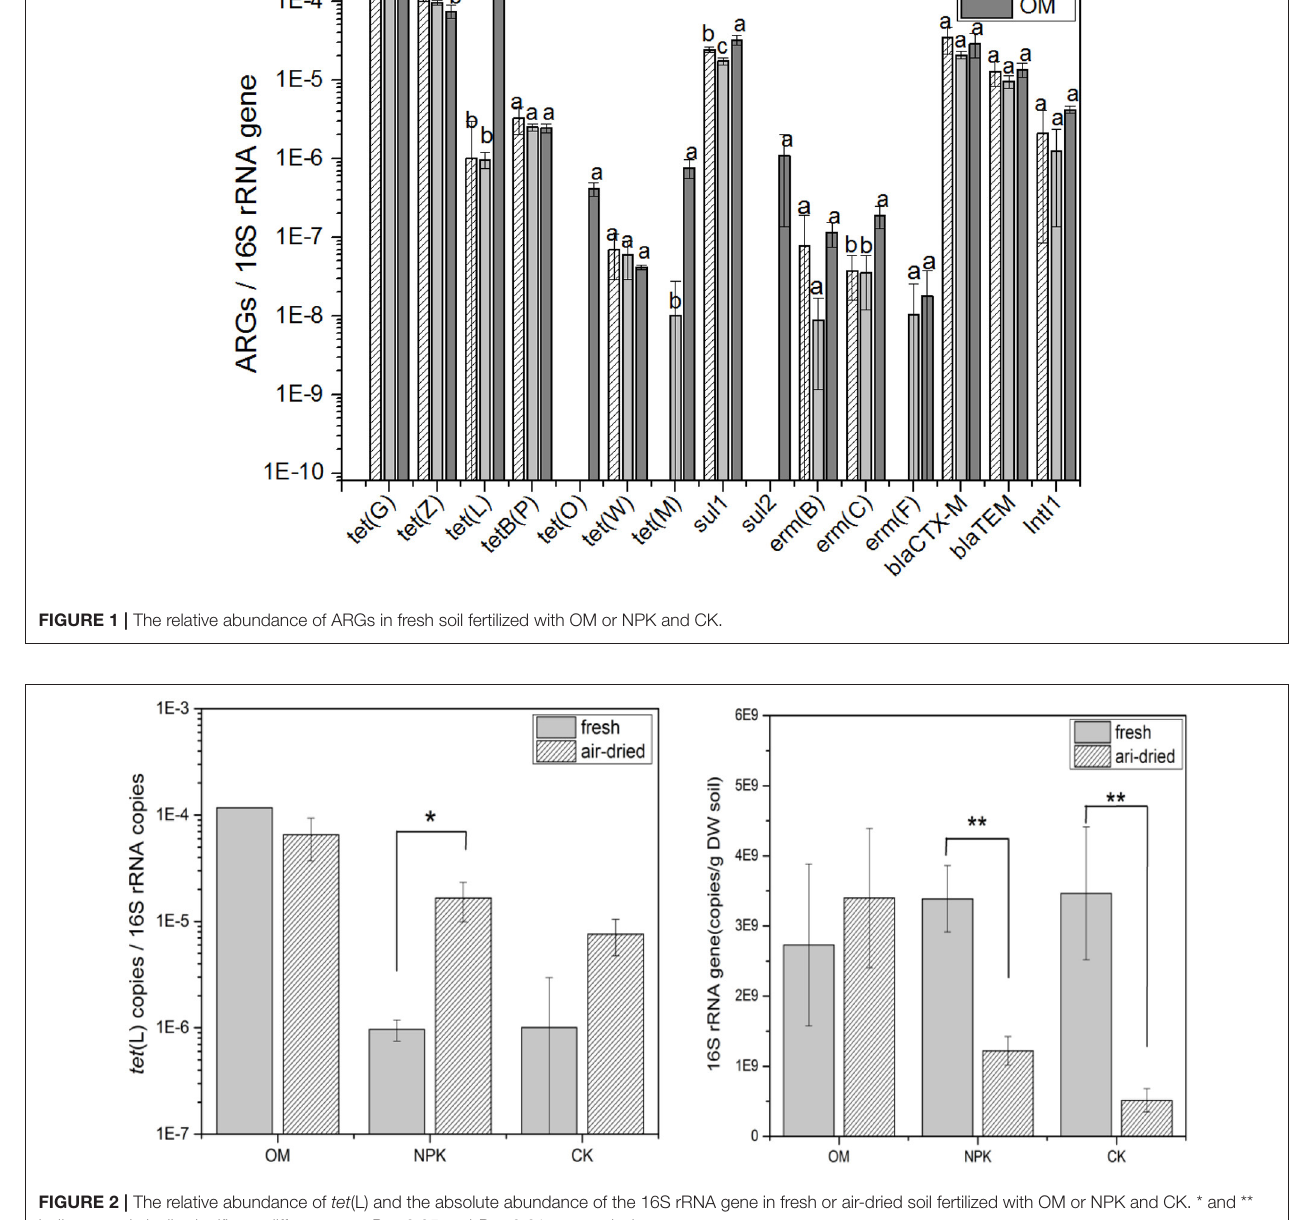
FIGURE 2 | The relative abundance of tet (L) and the absolute abundance of the 16S rRNA gene in fresh or air-dried soil fertilized with OM or NPK and CK. * and ** indicate statistically significant differences at P < 0.05 and P < 0.01,